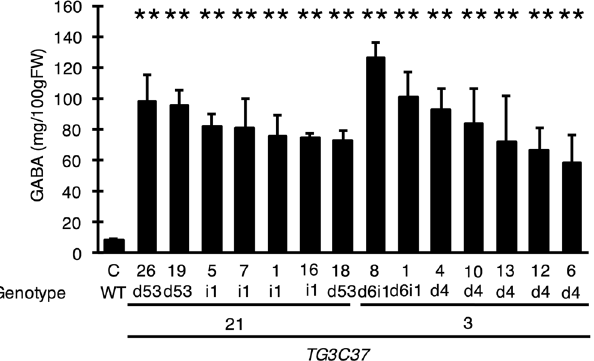
Figure 5. Red-stage fruit GABA content in the T 1 generation. GABA content of red-stage fruits (Breaker-stage + 10 days) was measured by HPLC. All lines were homozygous for TG3C37. Bars indicate standard deviation (n = 3) and asterisks indicate statistical differences in relation to control according to the Tukey-Kramer’s test ( * P < 0.05 and ** P < 0.01). ‘C’ is the control plant with WT